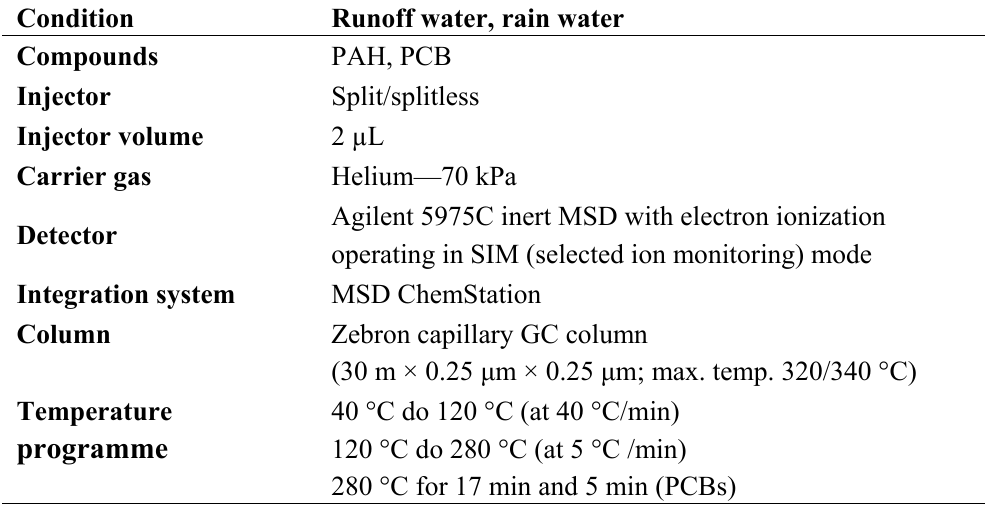
Table 2. Operating conditions of the GC-MS system.